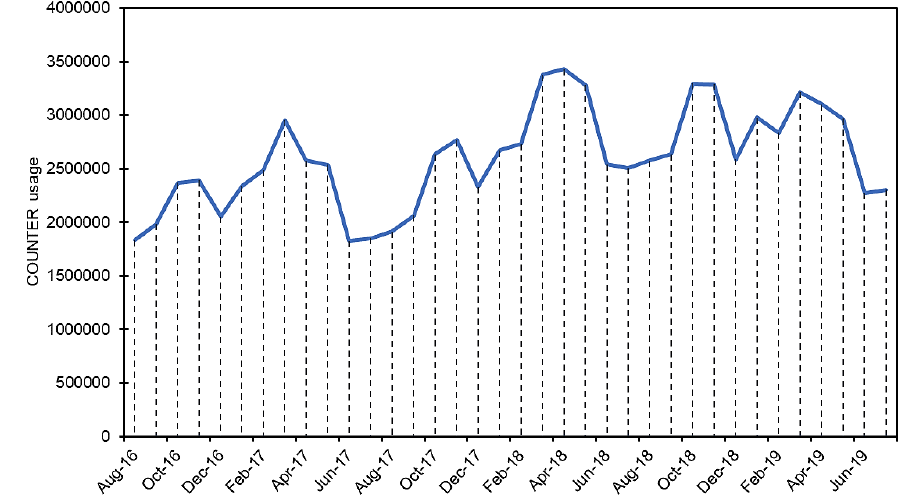
Figure 1. COUNTER-compliant usage data for 88 IRUS-UK member repositories